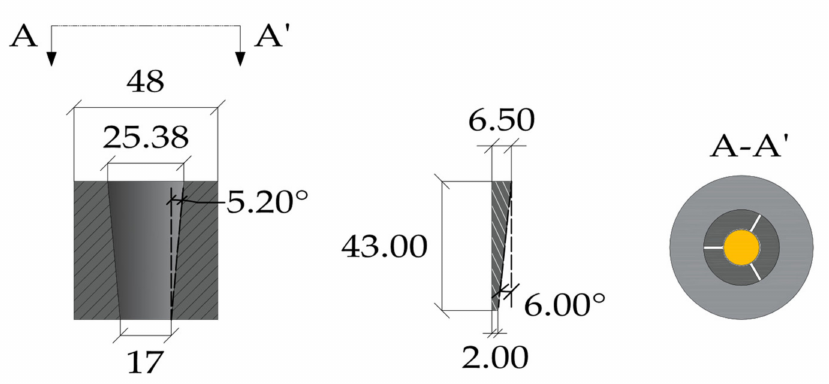
Figure 12. Traditional split wedge anchorage for ( φ = 12 mm) steel cable: geometry (dimensions in